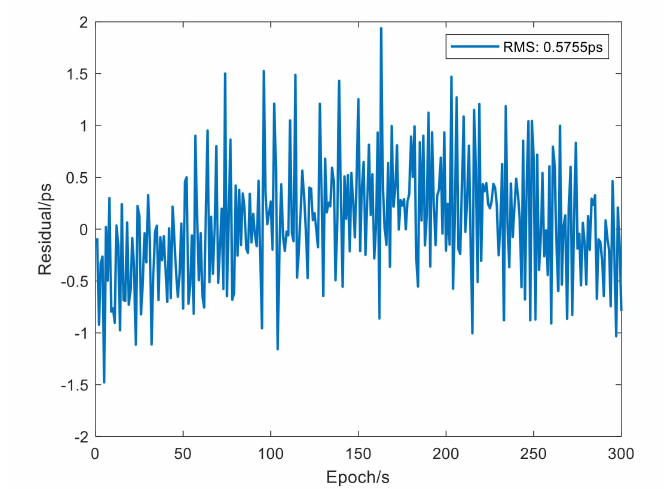
Figure 7. Satelliteground time synchronization residual. (After calculating the relative clock error between the satellite and the ground, the quadratic fitting model is used to fit the clock error, the residual after fitting represents the time synchronization residual, and the root mean square (RMS) of the residual represents the accuracy of time